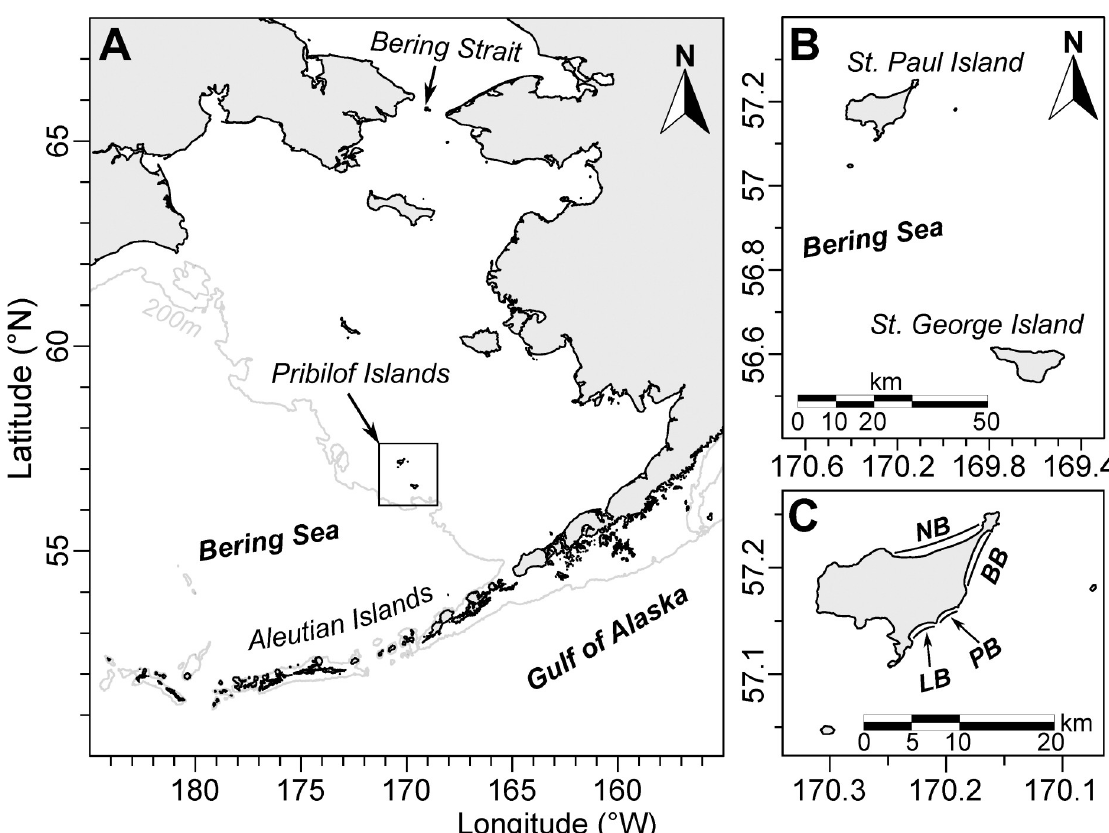
Fig 1. Location of St Paul Island within the Pribilof Island group in the Bering Sea. (A) The Bering Sea centered on the Pribilof Islands, Alaska, with the 200m (shelf break) isobath shown. (B) St. Paul and St. George Islands in the Pribilof Islands. (C) Surveyed beaches on